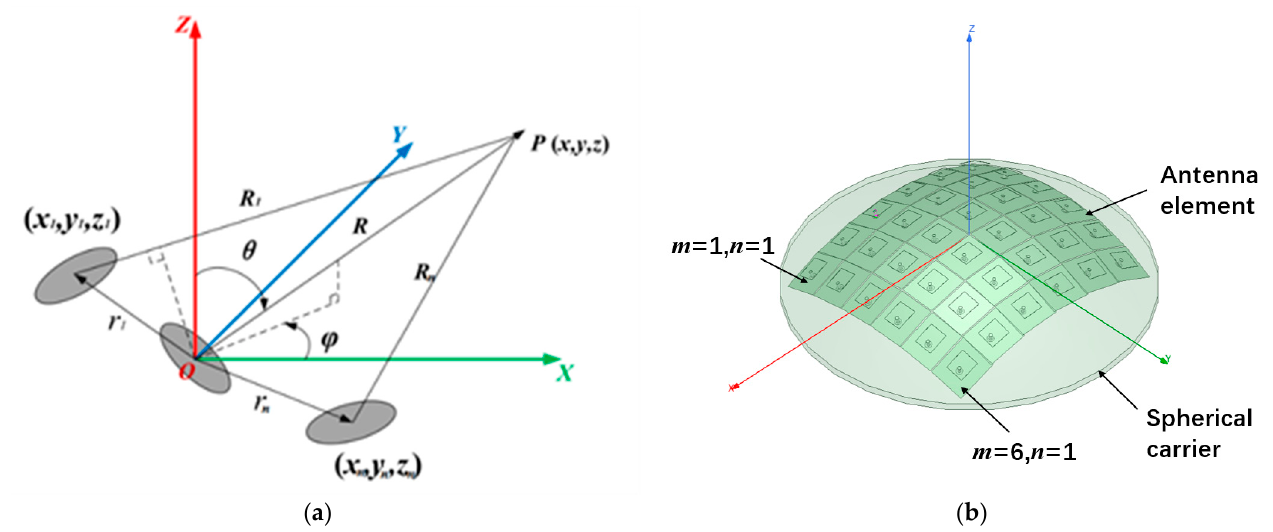
Figure 1. Simple model and spatial placement model of 3D conformal array antenna (( a ) diagram of space conformal array antenna, ( b ) model diagram established by HFSS).